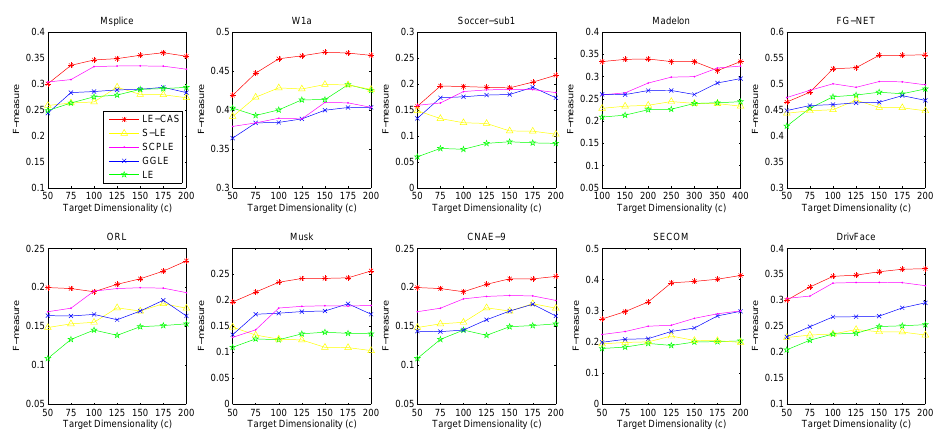
Figure 3. Results of F-measure on ten datasets (Msplice, W1a, Soccer-sub1, Medelon, FG-NET, ORL, Musk, CNAE-9, SECOM, DrivFace) under different target dimensionalities ( c ).